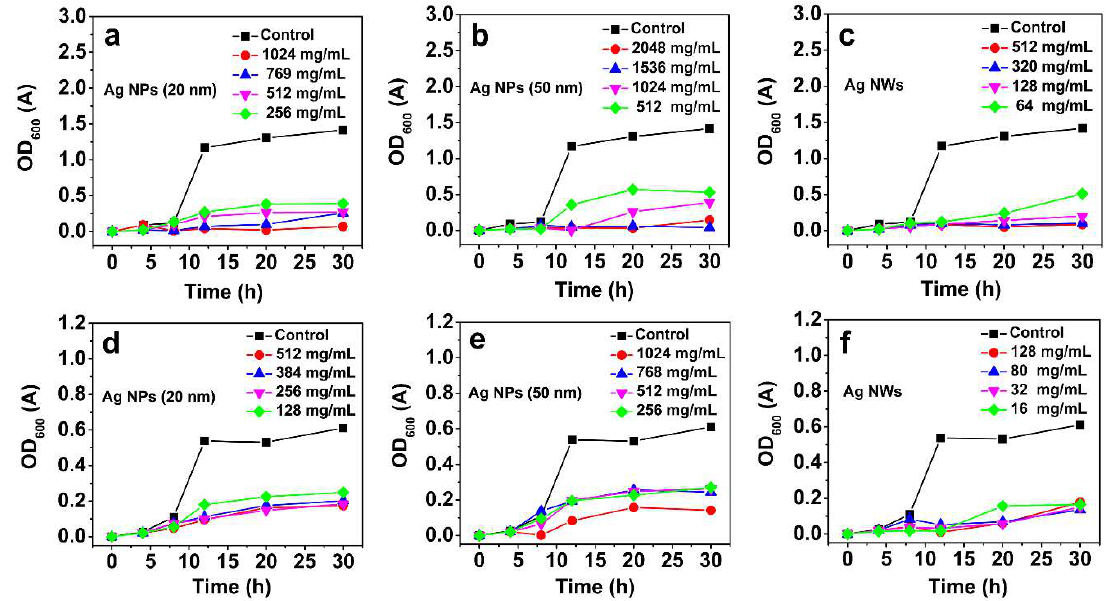
Figure 4. Growth curves of E. coli ( a – c ) and S. aureus ( d – f ) versus concentration.